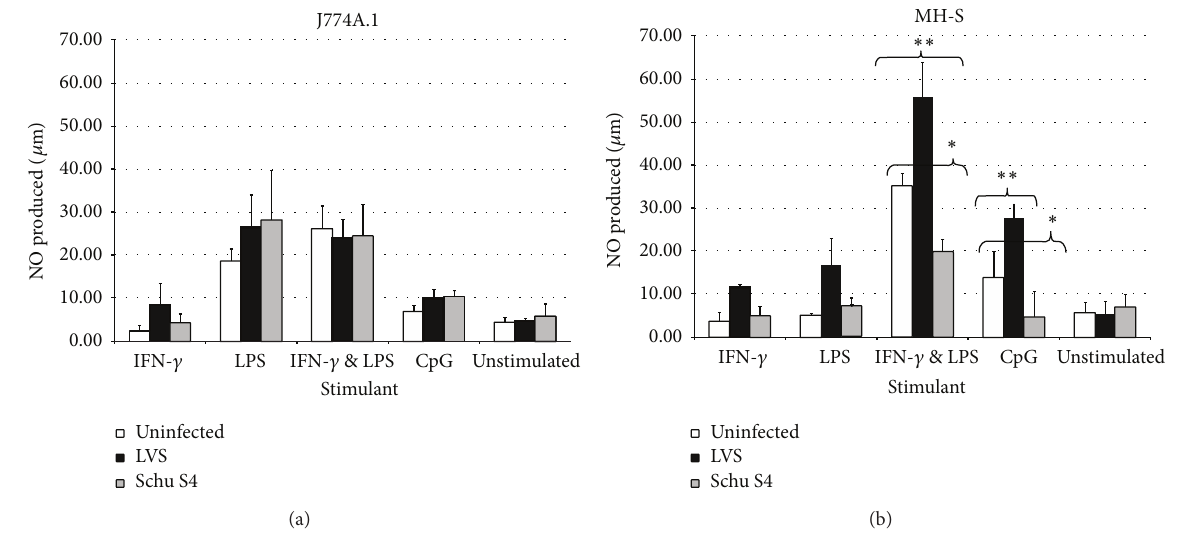
Figure 2: ((a) and (b)) Nitrite production from stimulated cells: J774A.1 (a) and MH-S (b). Stimulant concentrations added were IFN- 𝛾 (1 𝜇 g/mL), LPS (5 𝜇 g/mL), and IFN- 𝛾 + LPS (1 𝜇 g/mL + 5 𝜇 g/mL). Nitrite measurements were taken 24 hours after stimulation and/or infection. Values are the means and SEM from at least three independent experiments. Significant differences in production of nitrite from stimulation or stimulation and infection are marked with asterisks. Significance levels of ∗ 𝑃 < 0.05 , ∗∗ 𝑃 < 0.01 , and ∗∗∗ 𝑃 < 0.001 by Student’s 𝑡